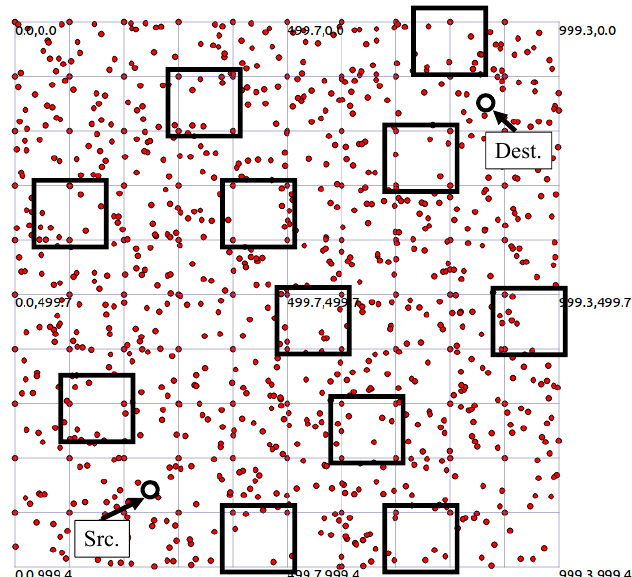
Figure 5. Simulation